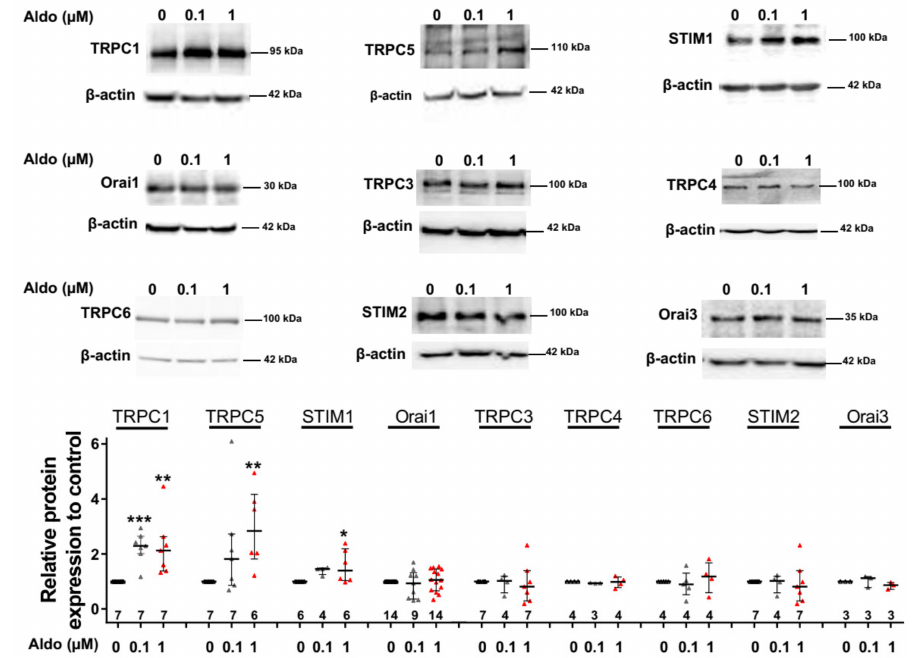
Figure 3. A 24-h aldosterone treatment increases transient receptor potential canonical channel 1 (TRPC1), TRPC5, and STIM1 protein expression in ARVMs. Representative Western blot (top panels) and pooled data (bottom bar graph) of TRPC1, TRPC5, STIM1, Orai1, TRPC3, TRPC4, TRPC6, STIM2, and Orai3 in ARVMs incubated for 24 h in the absence or in the presence of aldosterone (100 nM or 1 µ M). Protein levels were normalized by β -actin and are expressed as fold changes of that determined in untreated ARVMs for each cell isolation. Results are presented as scatter plots with median and interquartile range. Statistical significance was evaluated using one-way ANOVA (Kruskal–Wallis) followed by post hoc Dunn’s test for multiple comparisons. * p < 0.05 , ** p < 0.01, *** p < 0.001 vs.